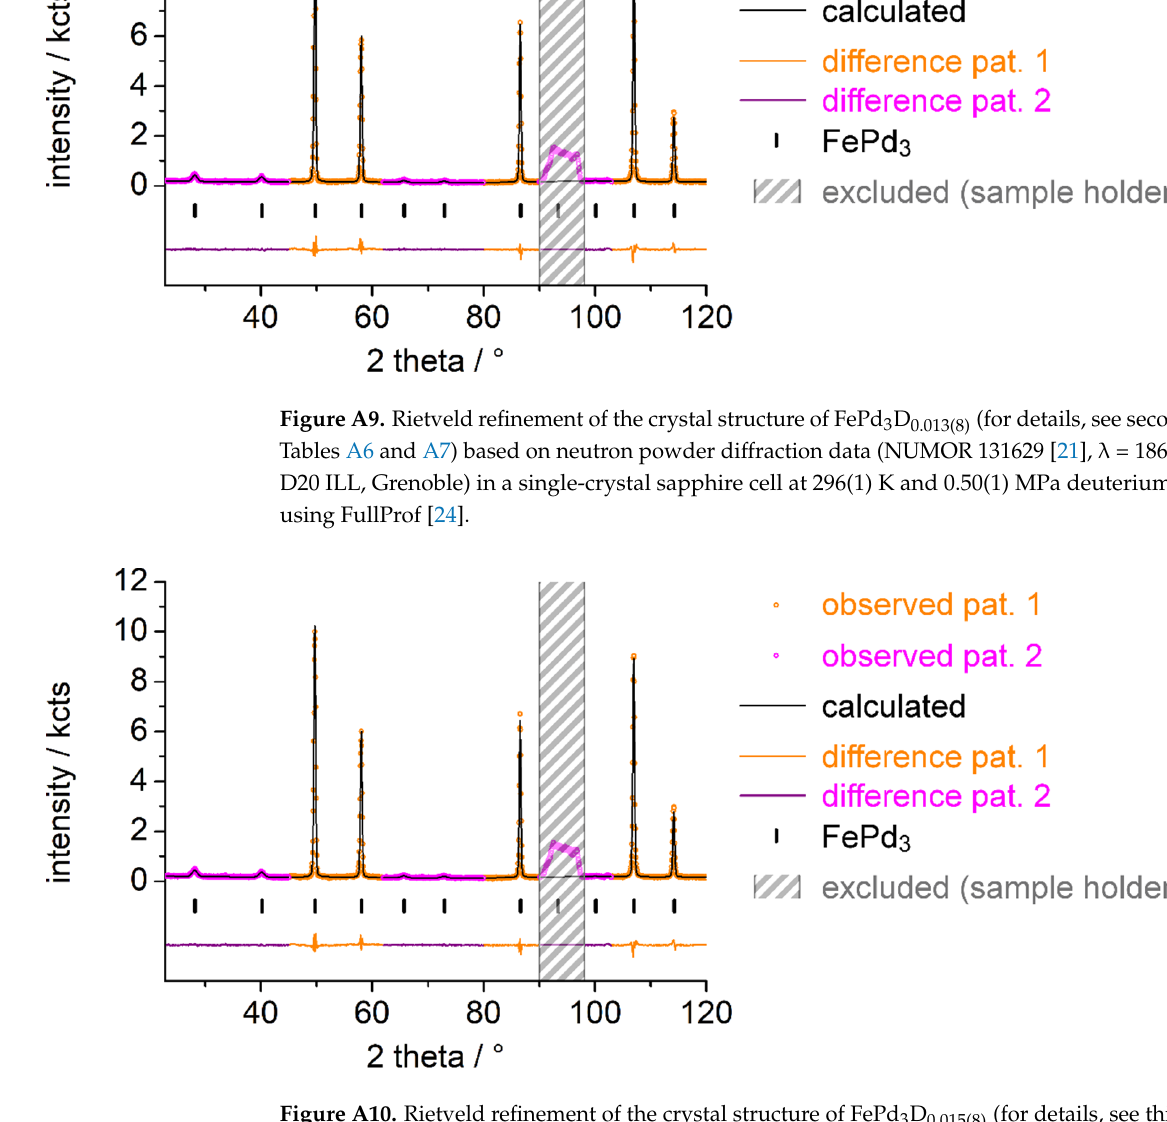
Figure A10. Rietveld refinement of the crystal structure of FePd 3 D 0.015(8) (for details, see third row in Tables A6 and A7) based on neutron powder diffraction data (NUMOR 131634 [21], λ = 186.80(2) pm, D20 ILL, Grenoble) in a single-crystal sapphire cell at 296(1) K and 1.00(1) MPa deuterium pressure using FullProf